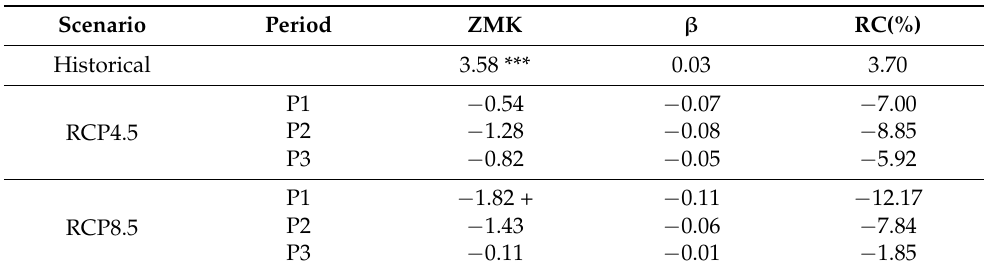
Table 5. Statistics of the Mann-Kendall test (ZMK) and the magnitude of trends approximated by Sen’s estimator (β ) for the De Martonne aridity index (I DM ), considering the historical period and different periods (P1, 2006 – 2035; P2, 2036 – 2065; P3, 2066 – 2095) until the end of the 21st century for